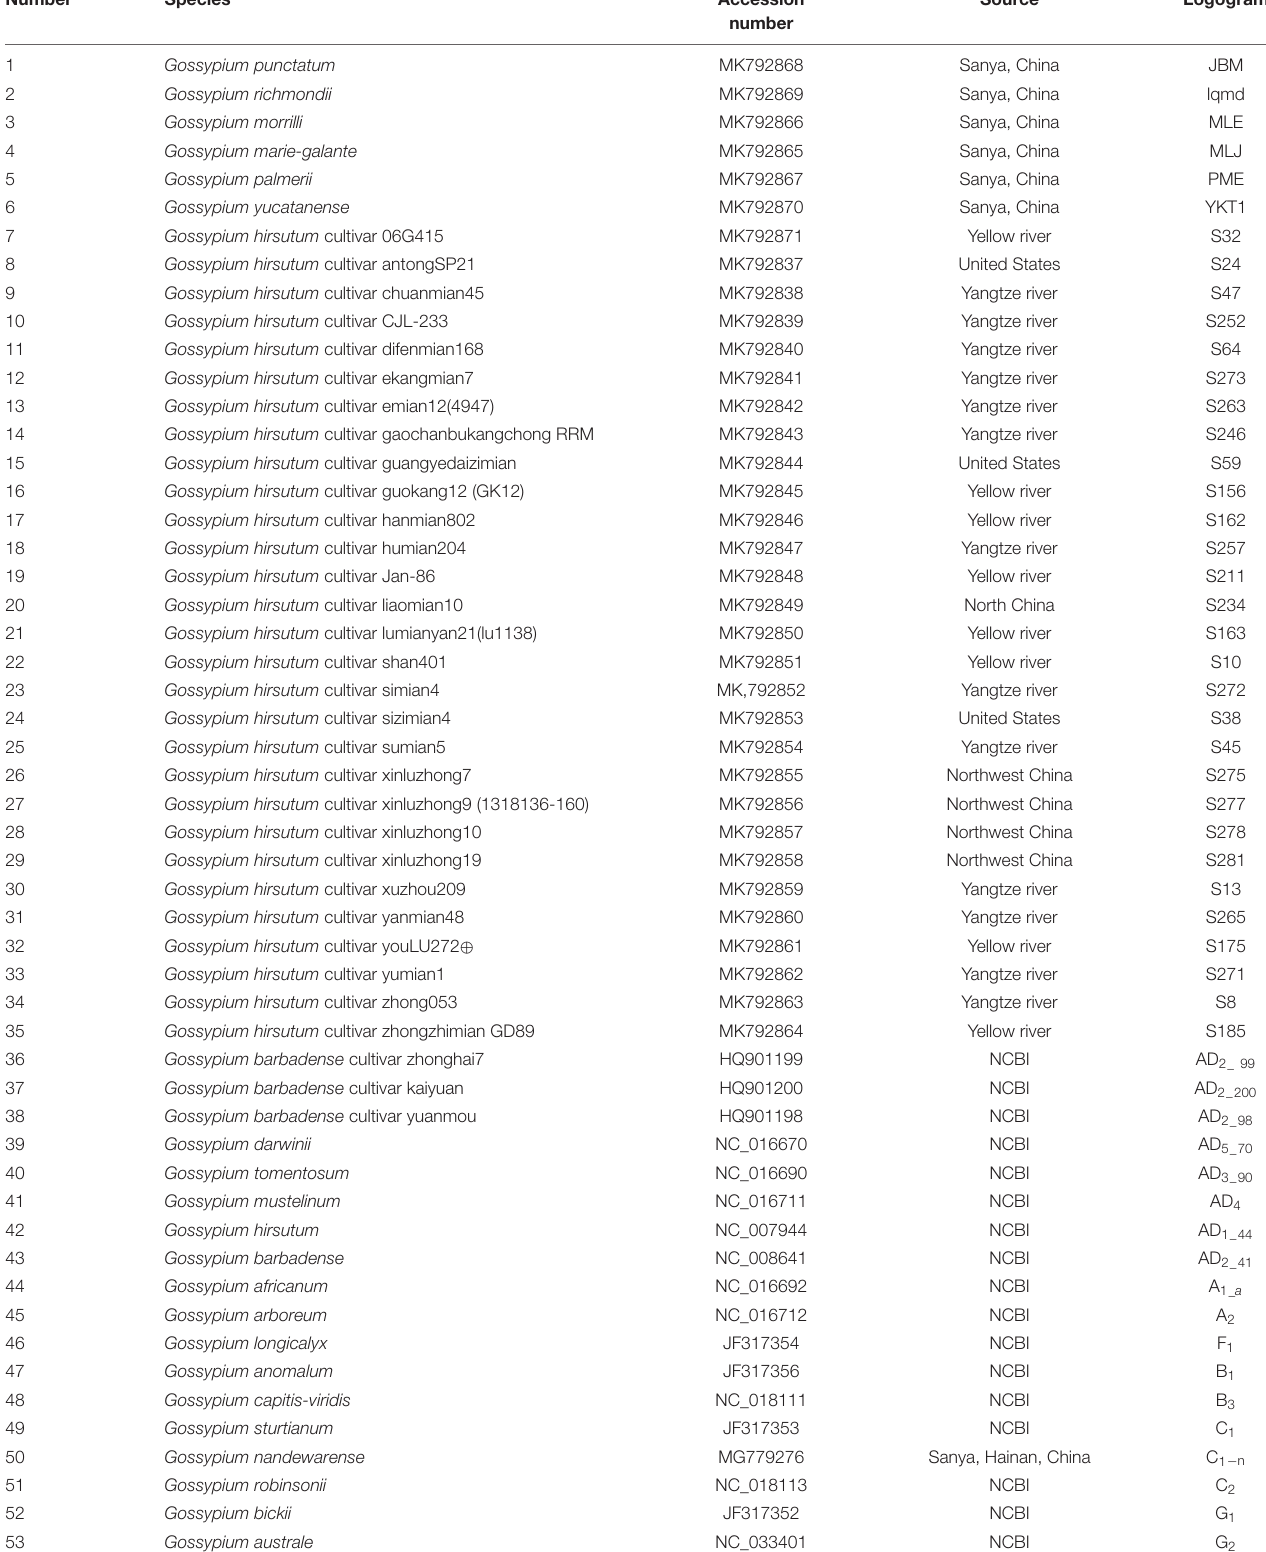
TABLE 1 | List of taxa sampled in this study and species accession numbers